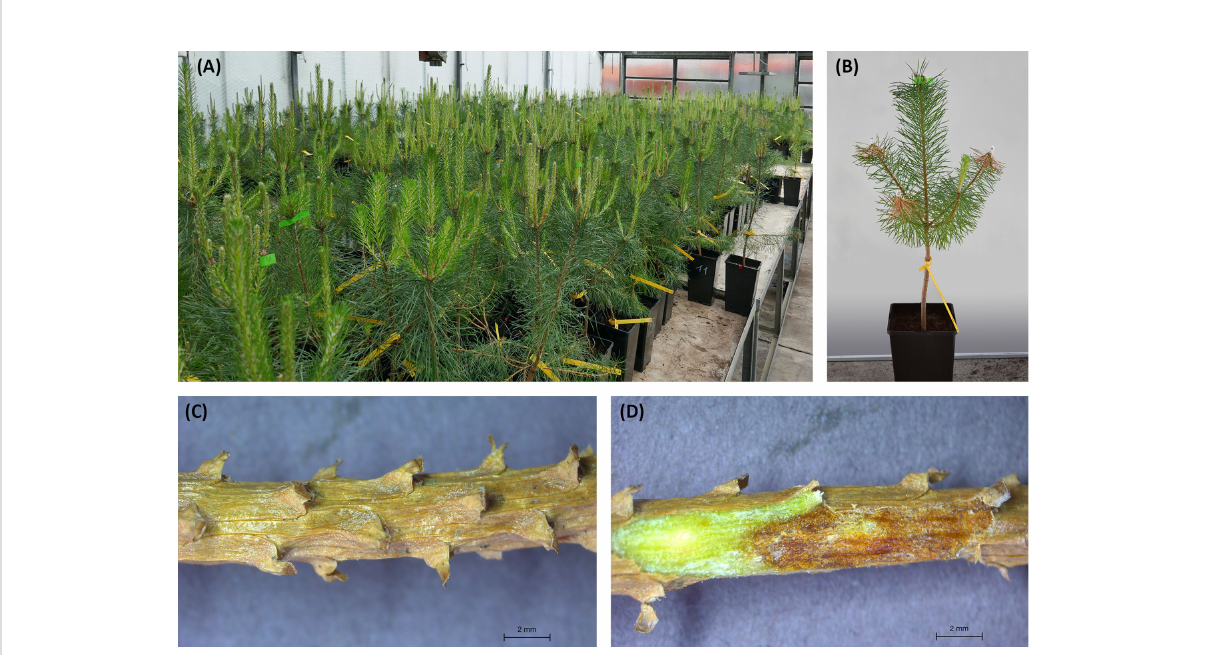
FIGURE 1 (A) Setup of Scots pines in the greenhouse; (B) symptoms due to Diplodia sapinea infections at the end of the experiment; (C) necrotic twig with bark; (D) necrotic twig with bark peeled off to measure the necrosis